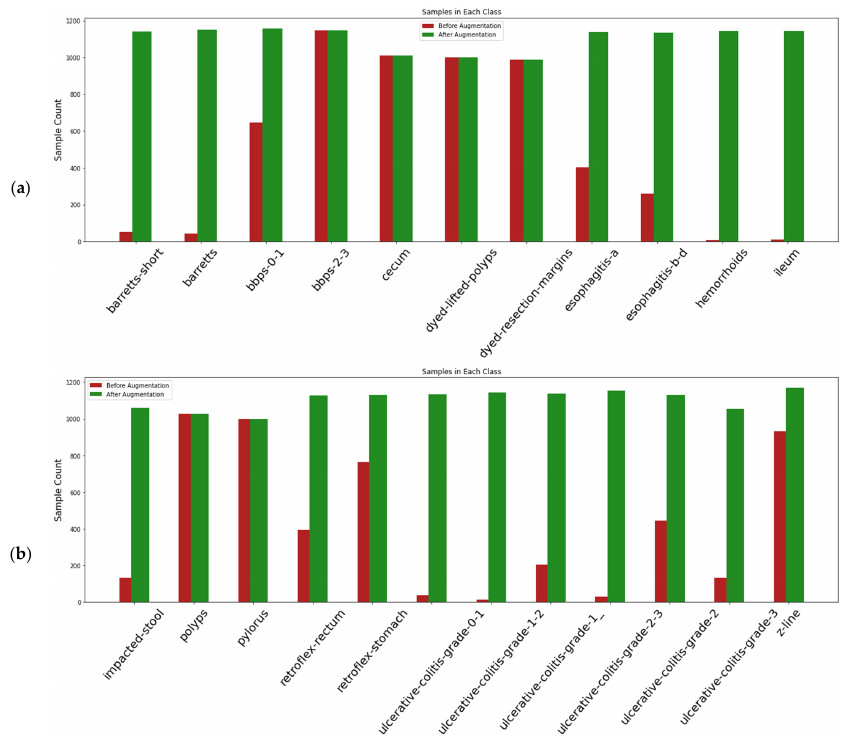
Figure 3. ( a , b ) Distribution of samples in each class before and after data